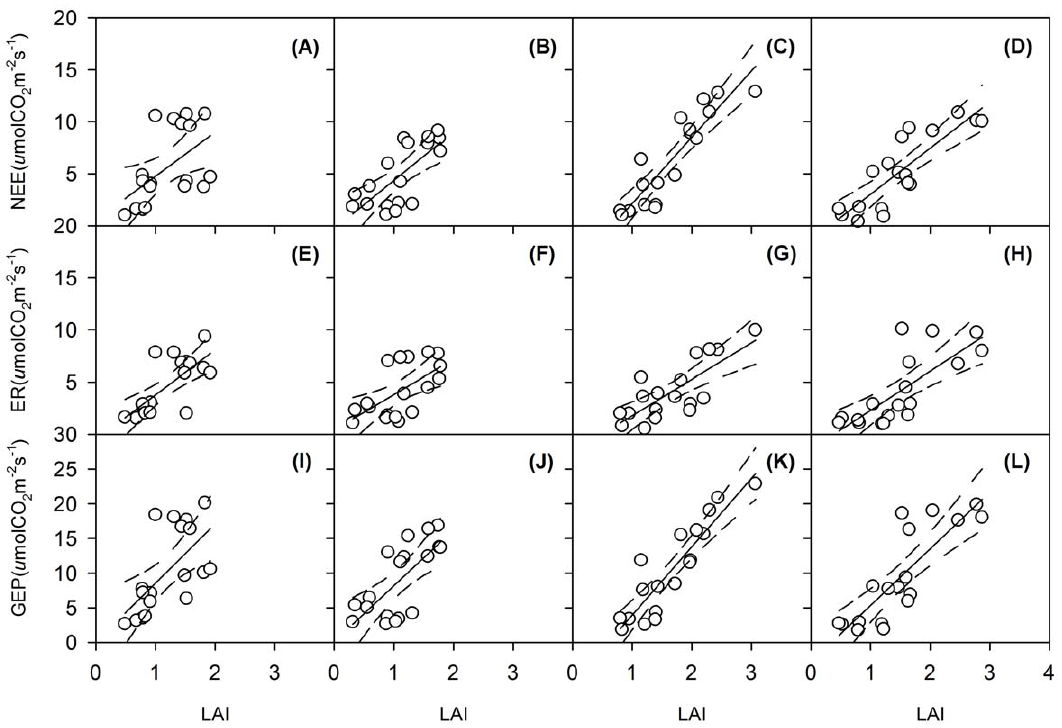
Figure 5. Temporal dependence of seasonal mean net ecosystem CO 2 exchange (NEE), ecosystem respiration (ER) and gross ecosystem productivity (GEP) on leaf area index (LAI) across the four treatments in May and June of 2006–2009. Regression lines (solid) and 95% confidence level (dotted lines) are showed. All the linear regressions are statistically significant ( P , 0.05). Regression equations and significance levels are provided in Table 4. Control plots (A,E,I); Warming plots (B,F,J); N addition plots (C,G,K); Warming and N addition plots